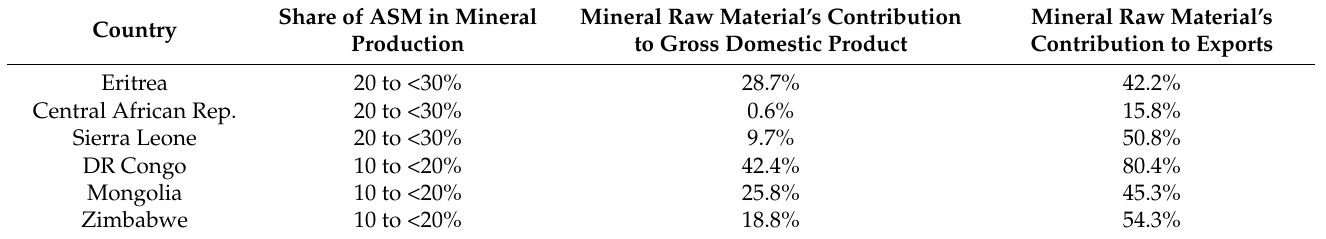
Table 4. Contribution of raw materials to the economies of selected developing nations with ASM share between 10% and 30% for 2019 (source